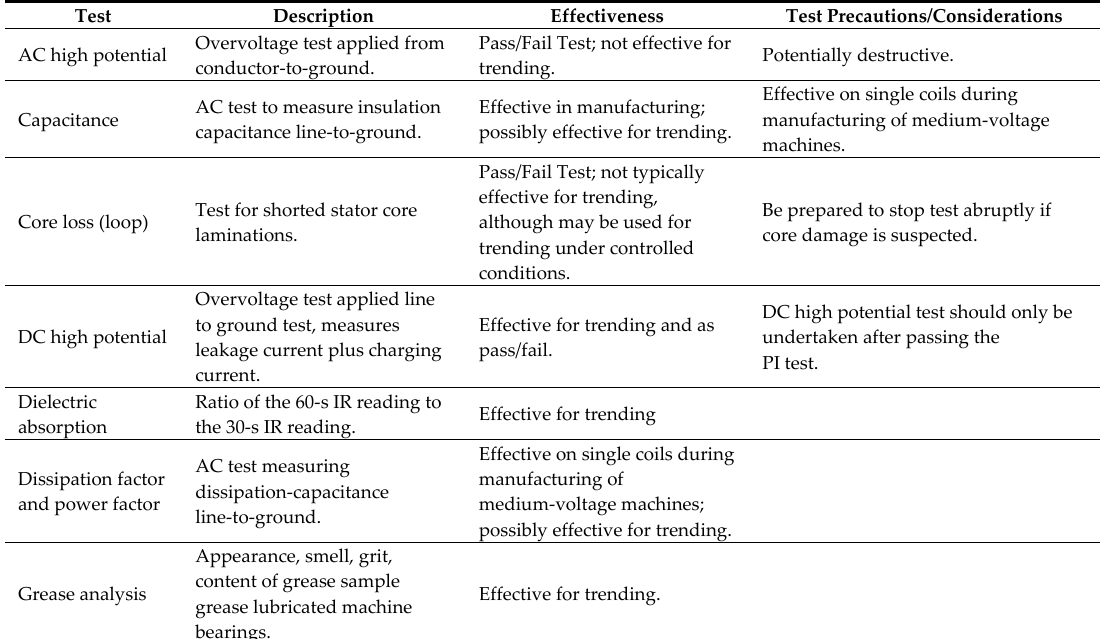
Table 9. Invasive